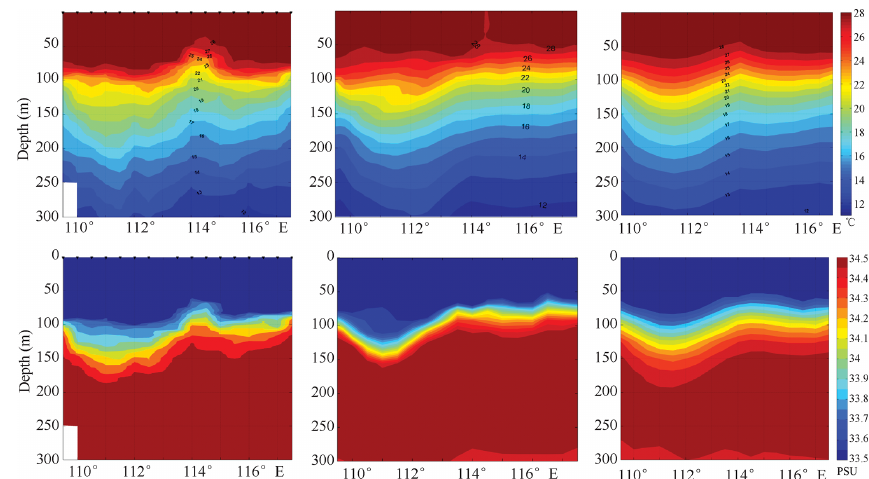
Figure 7. The vertical distributions of temperature (upper panels) and salinity (lower panels) for the layer of depth shallower than 300m along the section 10 ◦ N from the in situ observations of Nansha cruise (left column), Mercator Océan (middle column), and SCSOFS (right column).